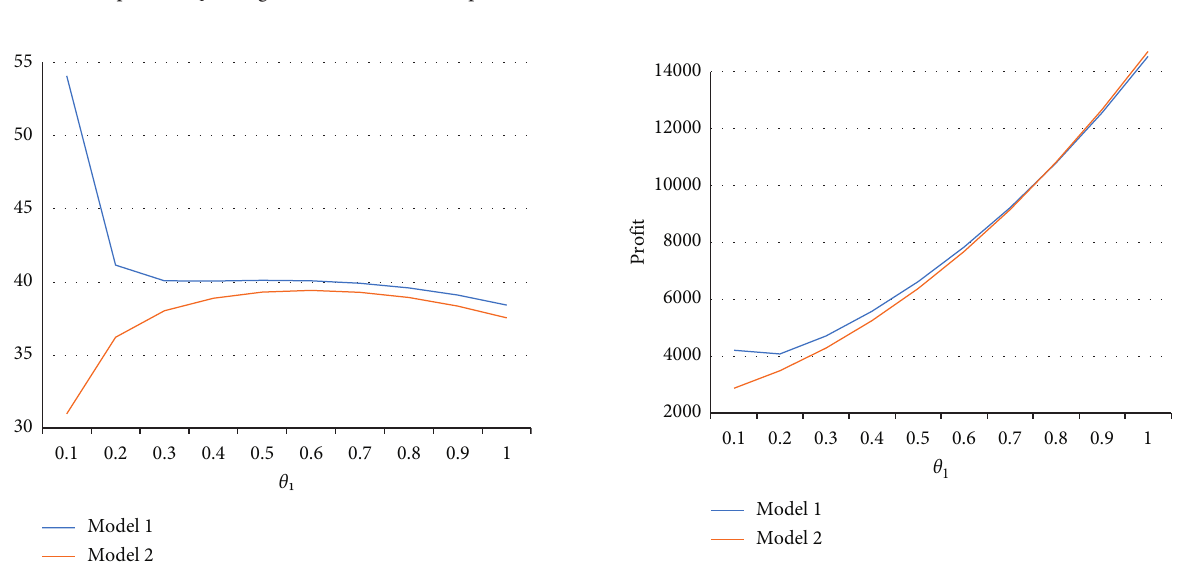
changes on manufacturers’ purchase. 1